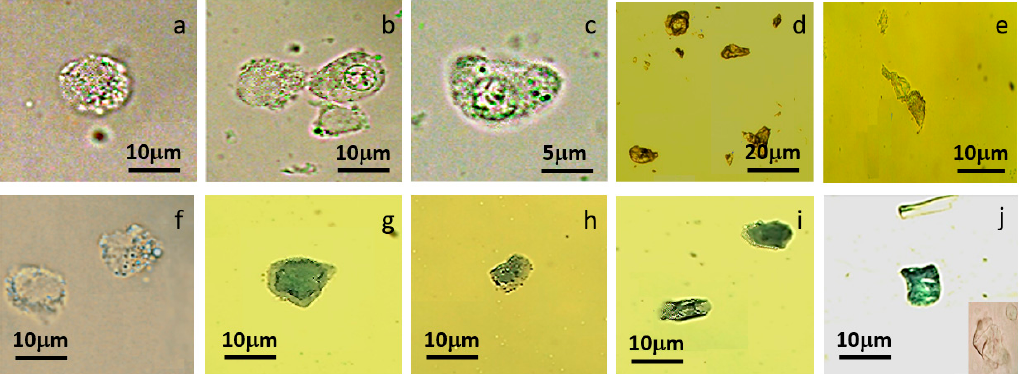
Figure 6. A panel of MCT cell micrographs after sorting through our predesigned spiral microchannel. ( a ) The external appearance of a viable sorted MCT cell was similar to fresh, non-degenerated MCT cells before sorting (Figure 4b). Remarkably, the cell morphology index (CMI) was equal to one according to the round shape. Nevertheless, all viable MCT cells were negative for trypan blue. ( b , c ) Plenty of the sorted MCT cells benignly degenerated. Their normal configurations were initially elongated or aberrant, with the escalated CMI varying from 0.22 (severe generation) to 0.625 (mild degeneration). ( d , e ) In the case of cell necrosis, sorted MCT cells were severely elongated or unidentifiable, bringing about debris formation. Nuclear dislocation or vanishment was stringently observed in these cells as well. Their CMIs were often lower than 0.22 or down to zero owing to their bizarre morphology. ( f ) The figure exhibits the trypan positivity of two benignly degenerated MCT cells after sorting, although their external features would be similar to non-degenerated MCT cells. ( g , h ) The figures depict two deformed cells fully stained with trypan blue. ( i ) The trypan blue exclusion assay identifies two malignantly degenerated MCT cells. The right upper cell was severely deformed and their nuclear-to-cytoplasm ratio was increased; meanwhile, the left lower cell was necrotized. Its morphology was distorted from that of normal MCT cells. Moreover, the nucleus (at the centre) deemed to be sloughed. ( j ) This figure depicts the positivity of trypan blue staining in MCT debris. The right lower inset illustrates the characteristics of MCT debris under plain light microscopy.